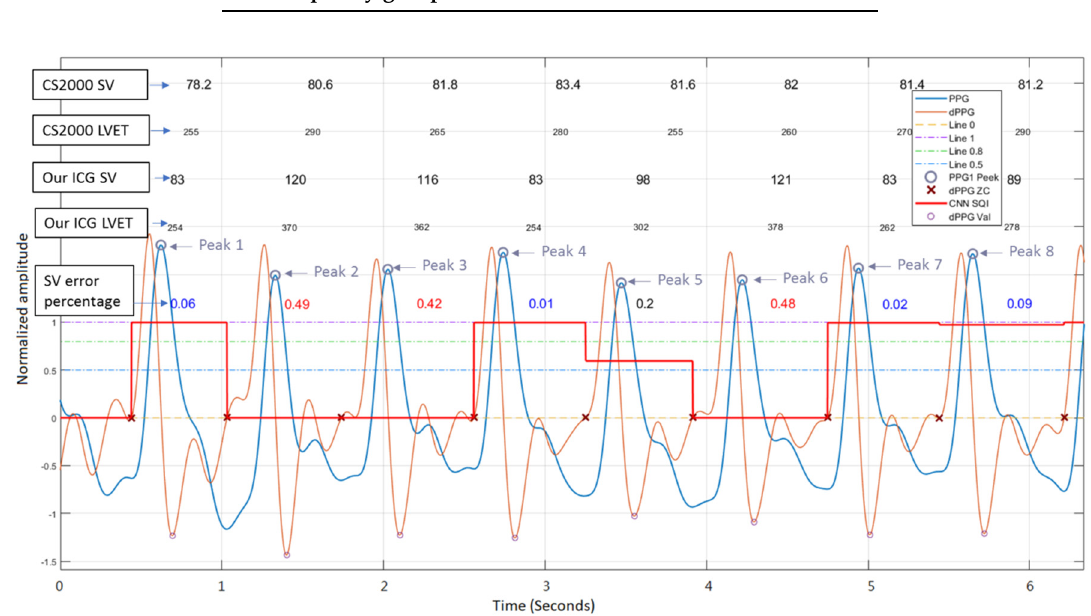
Figure 8. The results of SQI classification with the ResNet-50 model for the PPG (blue line) and DPPG (orange line) signals moderately corrupted by the baseline drift. The first and third rows of the data are the two SVs with medis ® CS 2000 and our ICG device, respectively, while the second and fourth rows are the two LVETs with medis ® CS 2000 and our ICG device, respectively. The fifth row denotes the error percentages of SV. The red line is the output value of the ResNet-50 model. The cross and circle symbols represent the first zero-crossing point and minimum-value point of the DPPG pulse,